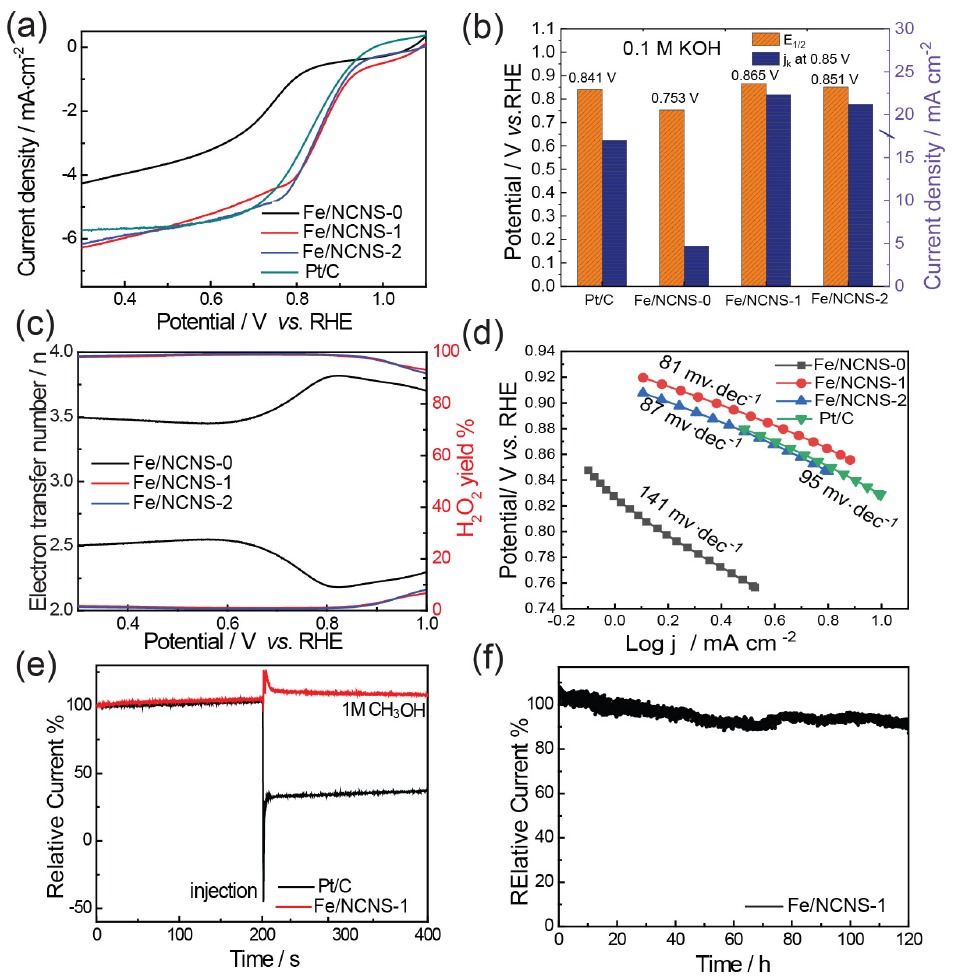
Figure 4. ( a ) LSV curves of Fe/NCNS-0, Fe/NCNS-1, Fe/NCNS-2 and commercial Pt/C at 1600 rpm · min − 1 in 0.1 M KOH; ( b ) comparison of j k at 0.85 V and E 1/2 of Fe/NCNS-0, Fe/NCNS-1, Fe/NCNS-2 and commercial Pt/C; ( c ) electron transfer number (n) and the yield of H 2 O 2 ; ( d ) Tafel plots of Fe/NCNS-0, Fe/NCNS-1, Fe/NCNS-2 and commercial Pt/C; ( e ) the tolerance to methanol of Fe/NCNS-1 and commercial Pt/C, ( f ) electrochemical stability test of Fe/NCNS-1 in 0.1 M KOH. The application of Fe/NCNS-1 as the air cathode in rechargeable ZABs was investi-